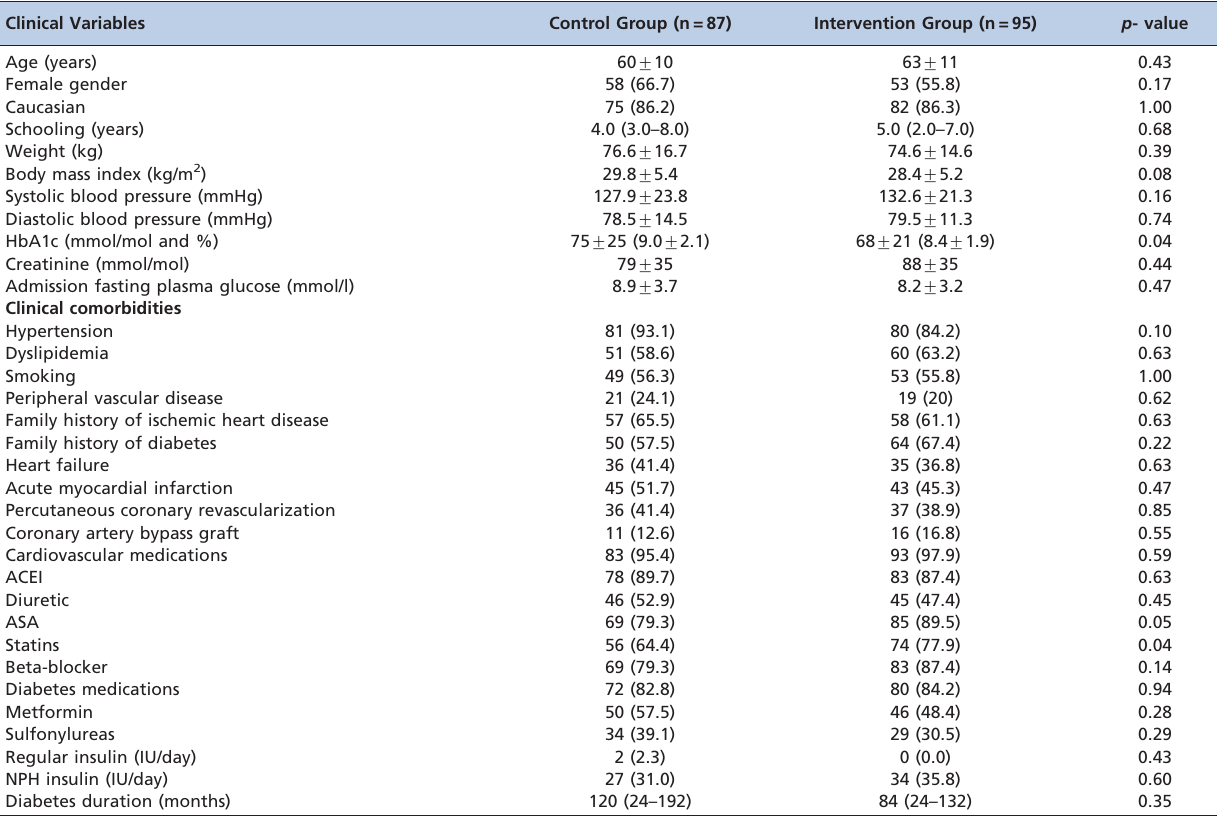
Table 1 - Baseline clinical characteristics of the patients.